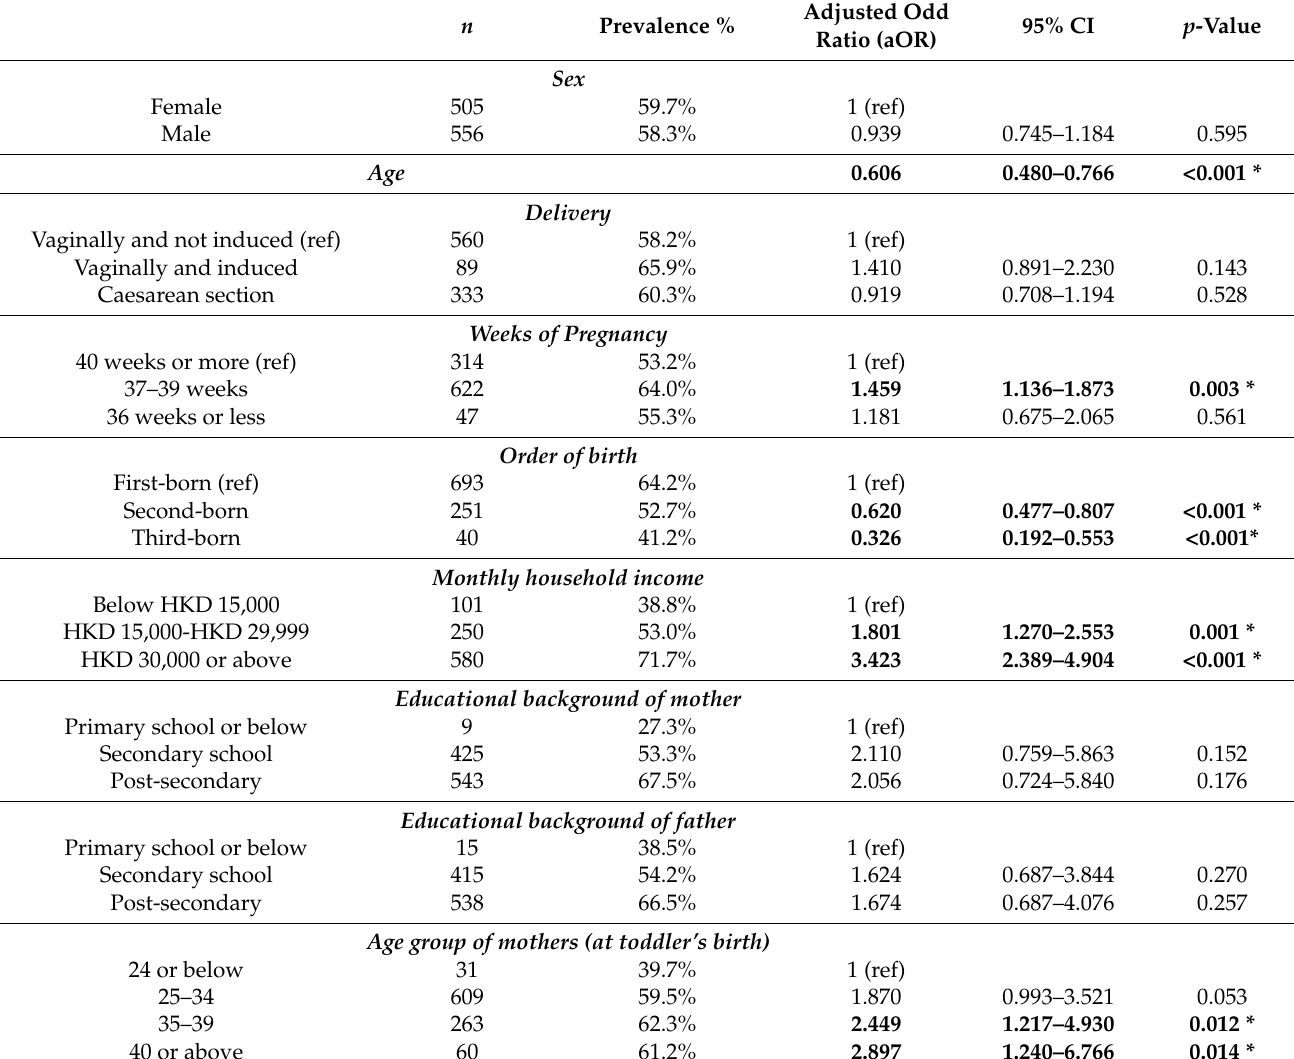
Table 2. Factors associated with uptake of recommended